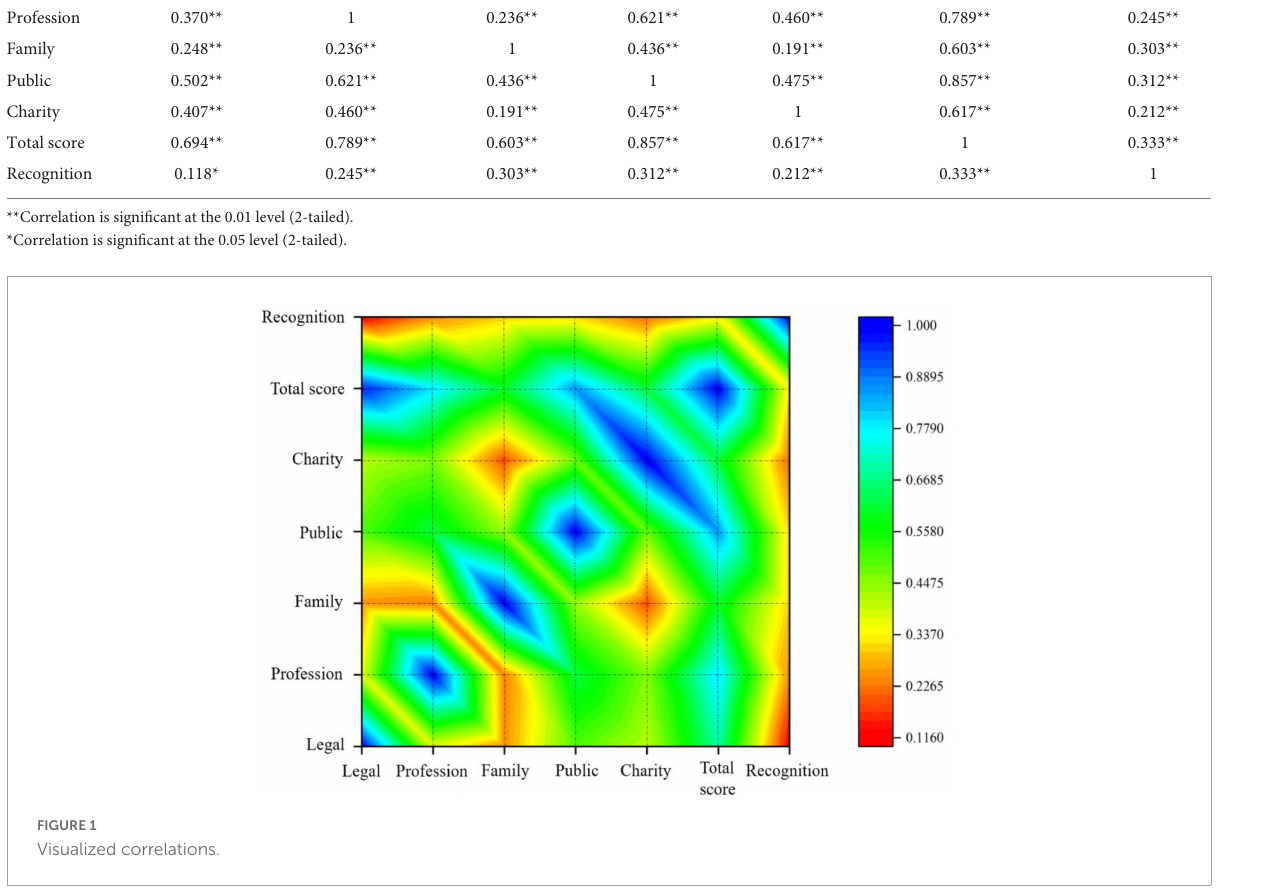
greater than 2.5 and less than or equal to 3.5 = 3;